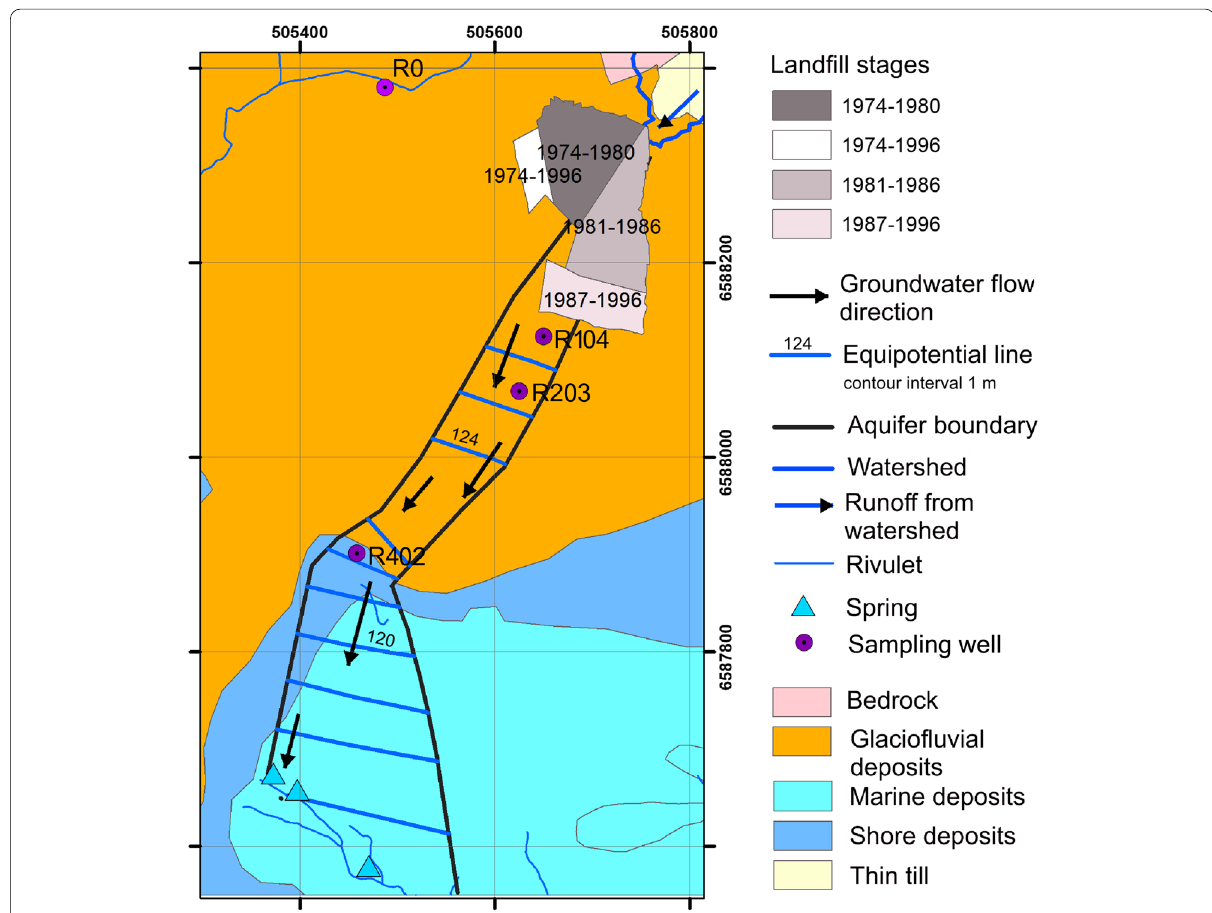
Fig. 1 Sample site showing the landfill, sampling wells and the site